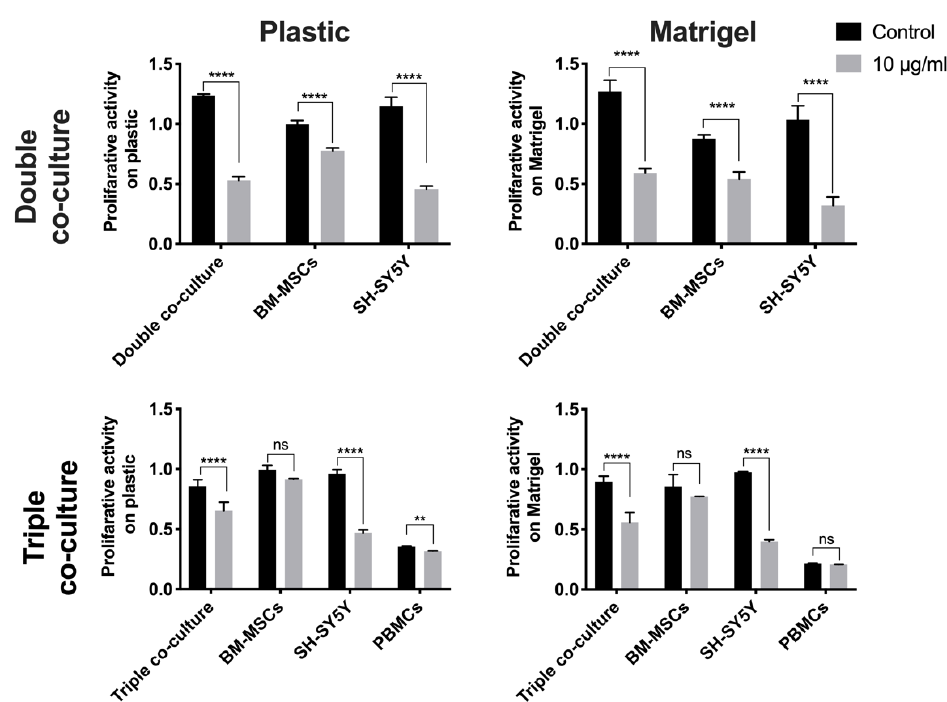
Figure 7. Analysis of the proliferation activity of BM-MSCs and SH-SY5Y cells after incubation with CDDP (10 µ g/mL) for 72 h. The results are presented as the mean ± SD (n = 5); **— p < 0.01; ****— p < 0.0001; ns—no statistically significant difference.